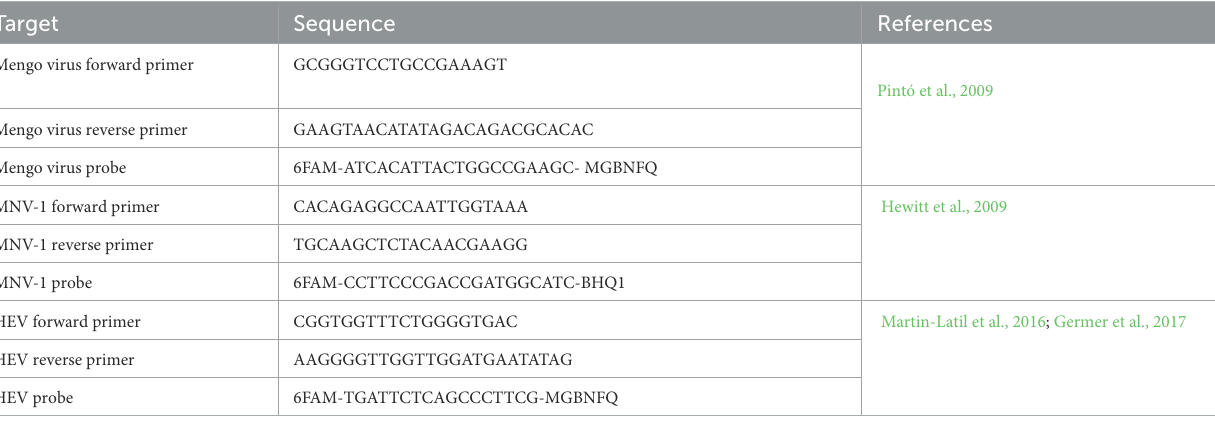
TABLE 1 Primers, probe sequences, quencher, and dye used for the detection of the virus by RT-qPCR.